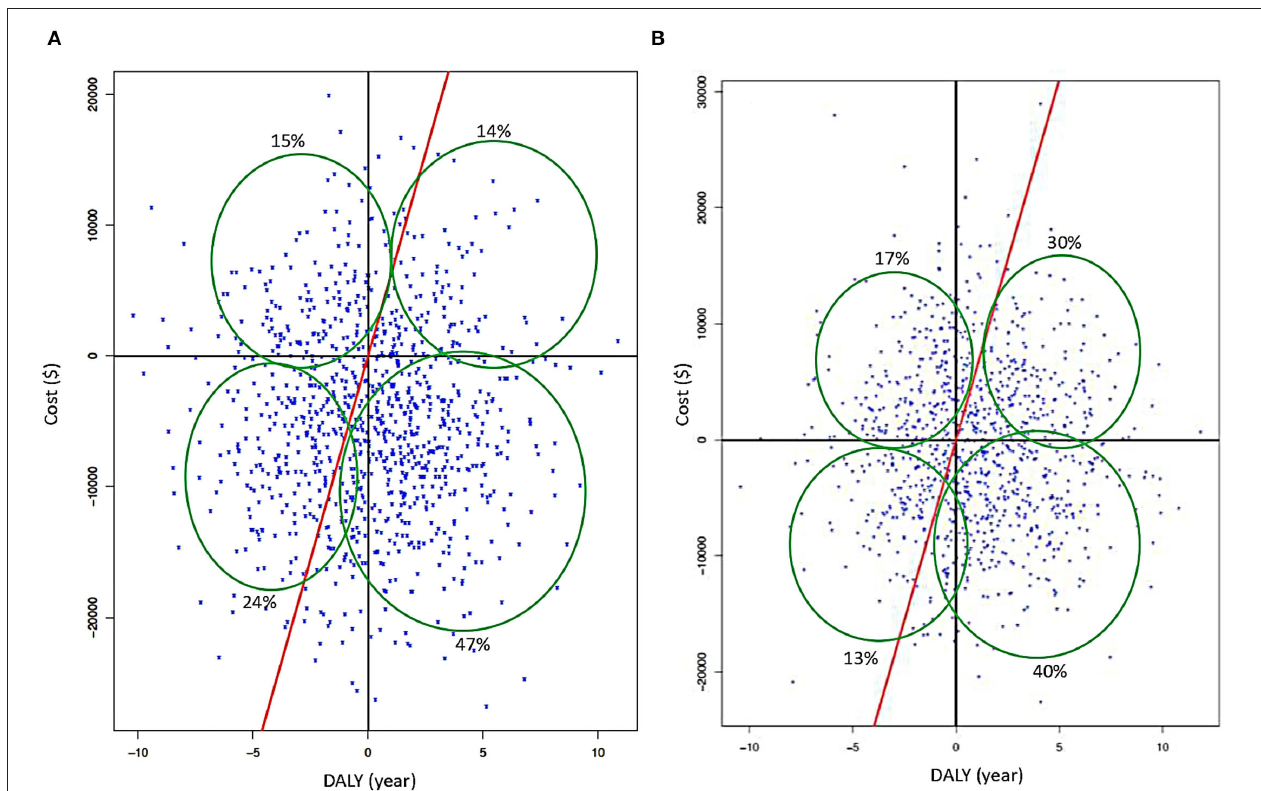
FIGURE 2 | (A) Cartesian plane from PSA when an early screening is applied with deterministic data. (B) Results of PSA for early screening using stochastic data (red continuous line represents GDP’s threshold; cost is in American dollars and DALYs in